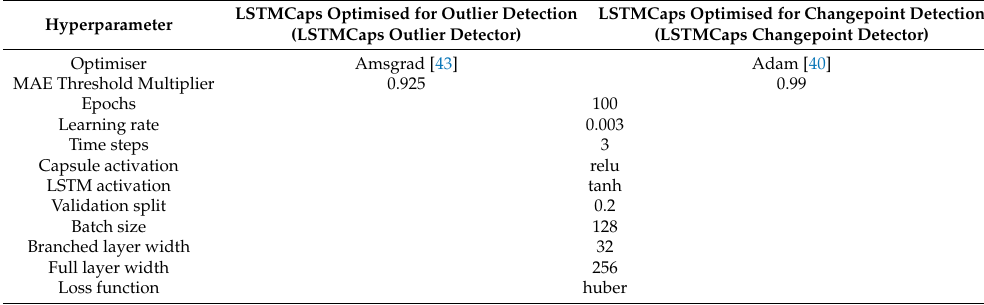
Table 10. Optimal hyperparameters used to maximise outlier detection (left) and changepoint detection (right).